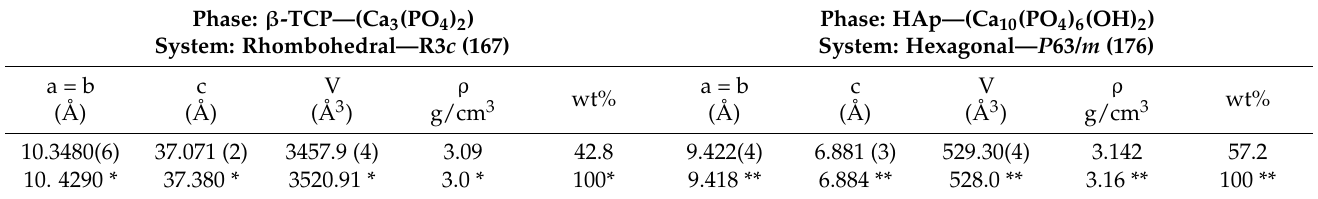
Table 1. Fractional mass (wt%), quality factors and structural parameters obtained by the Rietveld